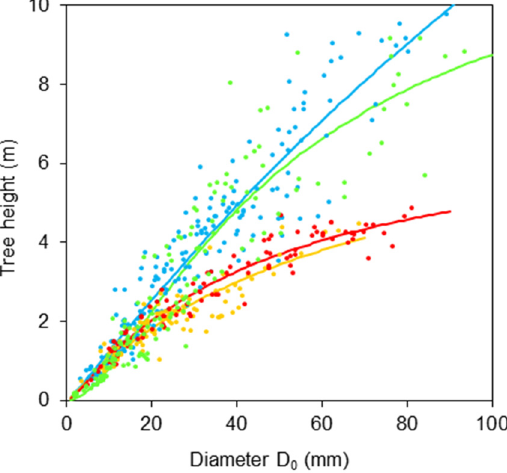
Figure 2. Relationships between tree height and stem base diameter D 0 for common aspen (blue), goat willow (orange), rowan (red) and sycamore (green), see Table 2 for formula and statistical characteristics.